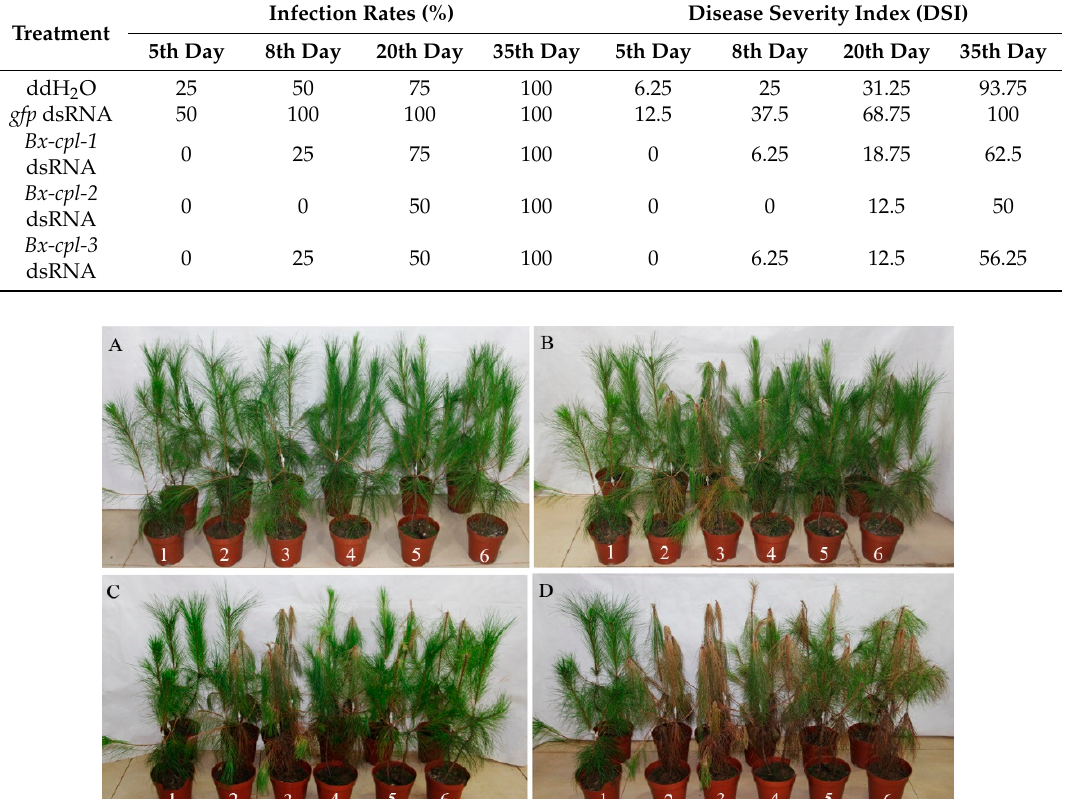
Table 1. Symptoms of Pinus massoniana caused by B. xylophilus treated with dsRNA.